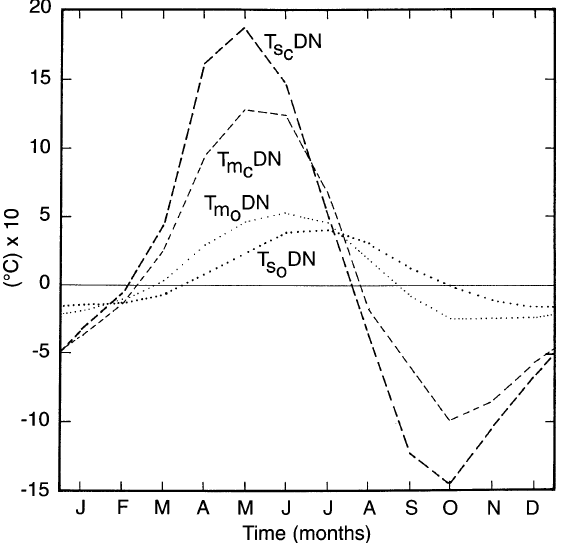
Fig. 6. Average over the total integration region of the ocean surface and continental ground temperature anomalies together ( thick con - tinuous line ), the continental ground temperature anomalies ( dashed lines ), the ocean surface temperature anomalies ( dotted line ), the mean tropospheric temperature anomalies ( thin continuous line ), and the insolation anomalies ( dashed - dotted line ) for 4 kyears AP. The ordinate to the left is for temperature anomalies in 0.1 ° C and to the right is for insolation anomalies in Wm (cid:126)(cid:50)